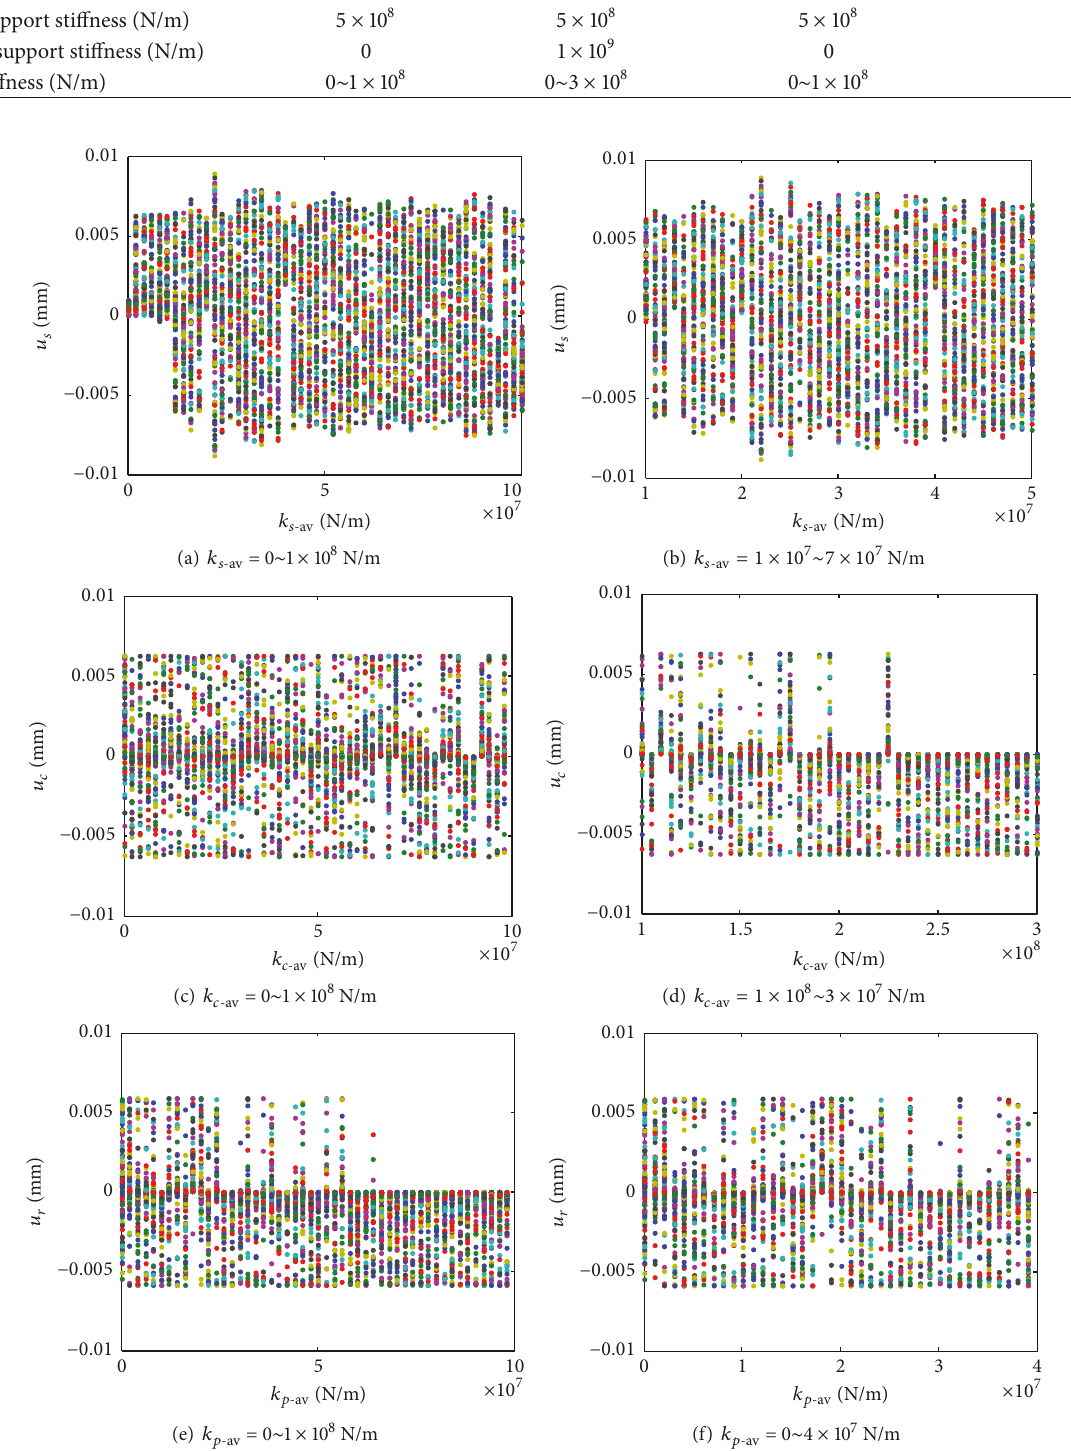
Figure 5: Bifurcation with average mesh